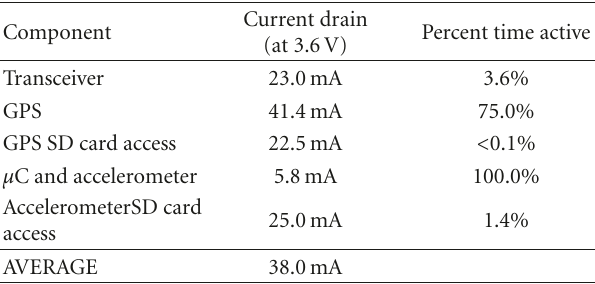
Table 5: Measured power consumption and percent time active per component for the AA battery test.